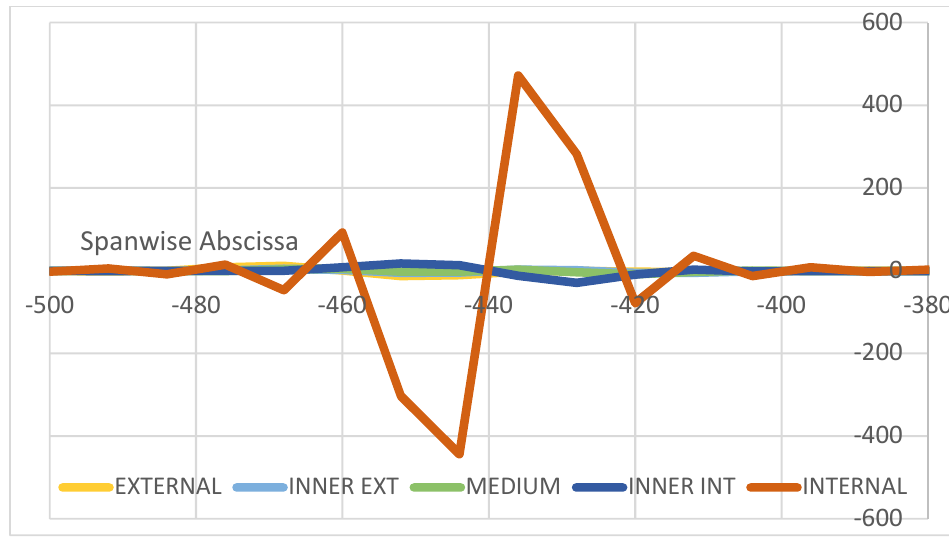
Figure 27. Strain difference, consequent local adhesive imperfections placed at different stations along the C-spar top cap, as measured by an optical fiber deployed at the inner part of the cap itself, within the bonding layer.